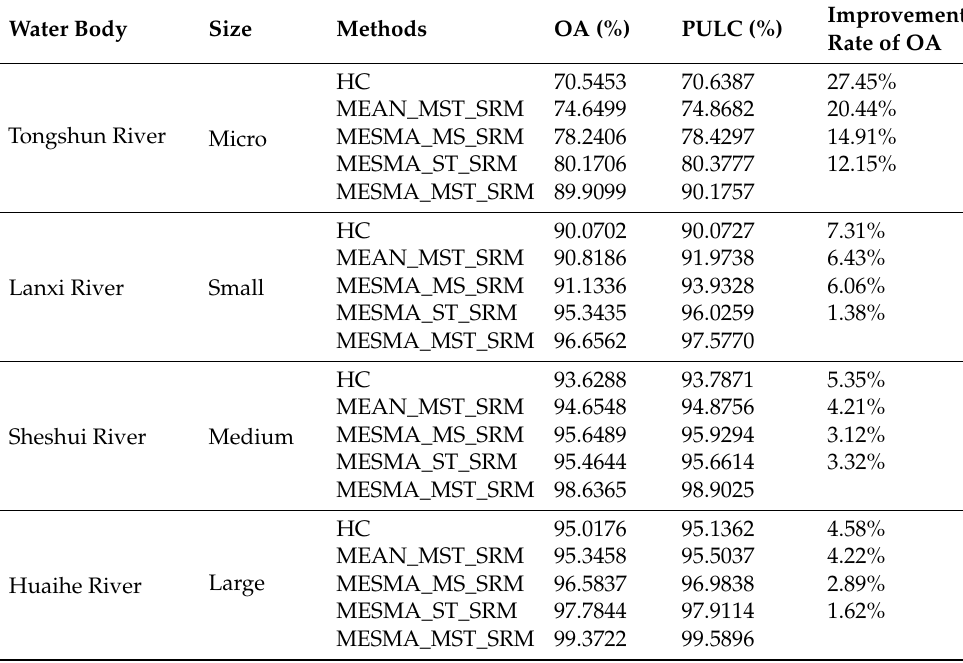
Table 2. Accuracy statistics comparison for different ribbon-like water